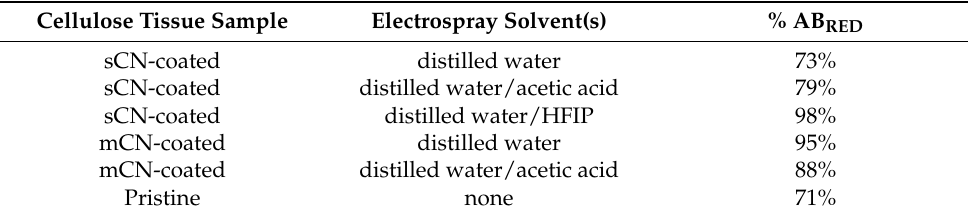
Table 1. Average metabolic activity given as AlamarBlue reduction percentage (% AB red ) performed at 24 h performed on HaCaT cells in presence of cellulose tissue coated via different CN/solvent suspensions ( n =